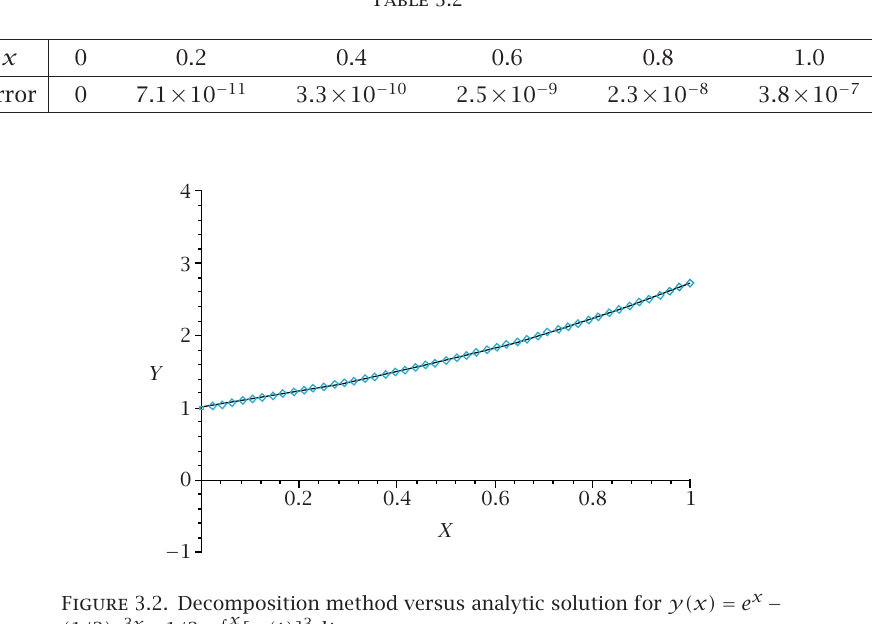
A comparison of the approximate solution from the decomposition method with the exact solution y(x) = e x of the integral equation at x = 0, 0 . 2, 0 . 4, 0 . 6, 0 . 8, and 1 .